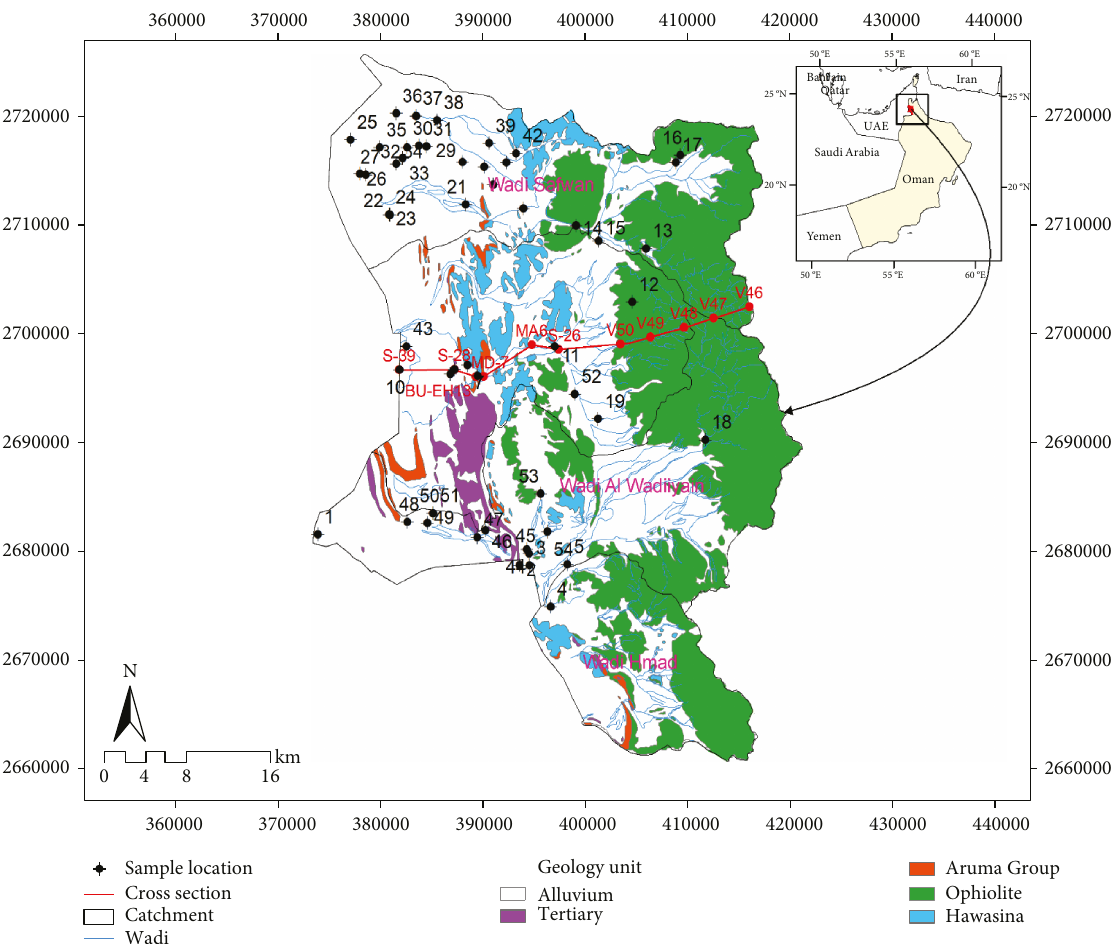
Figure 1: Study area, geology, and sample